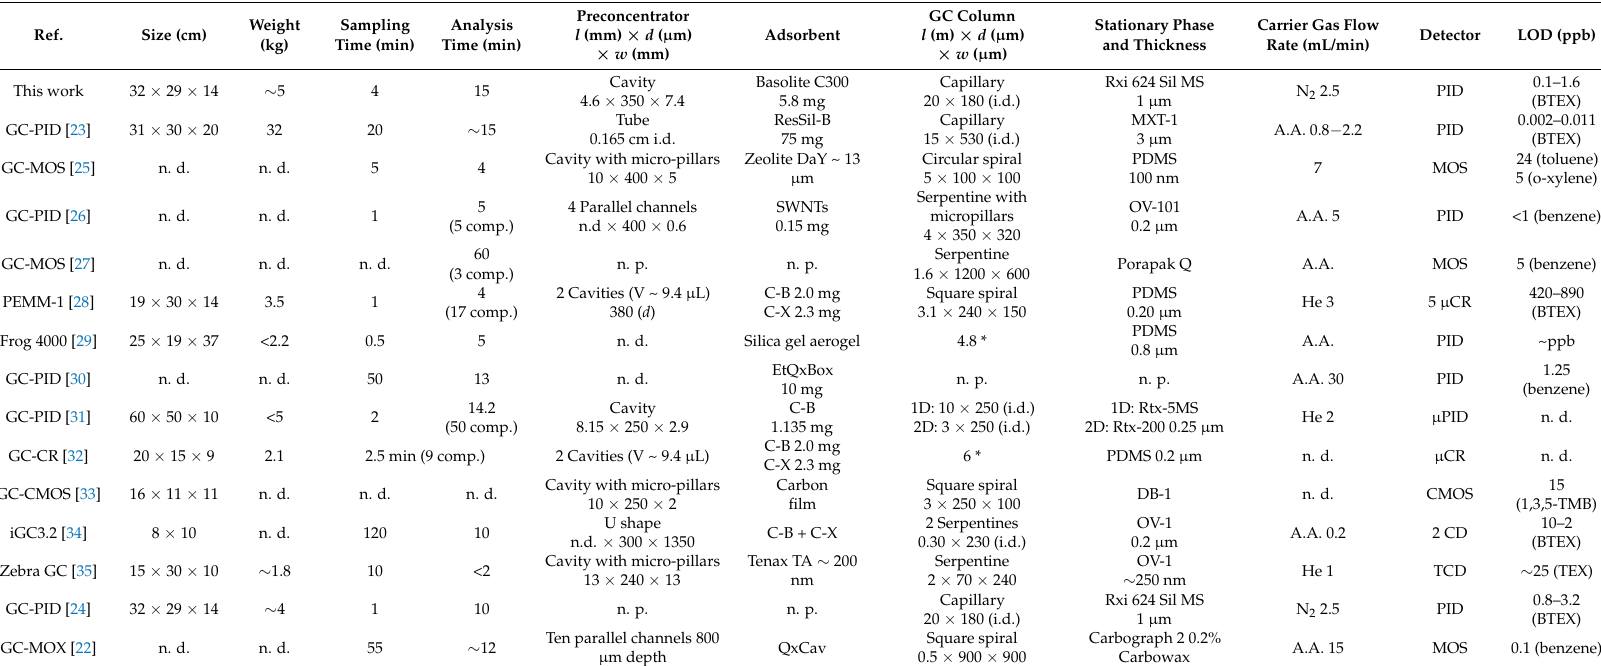
Table 1. Most representative compact gas chromatographs (GC) for BTEX analysis over last decade.